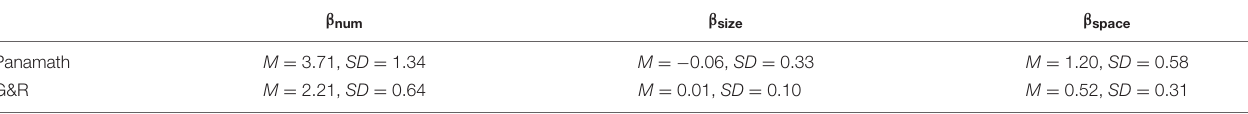
TABLE 5 | Mean and standard deviation of the parameter estimates.